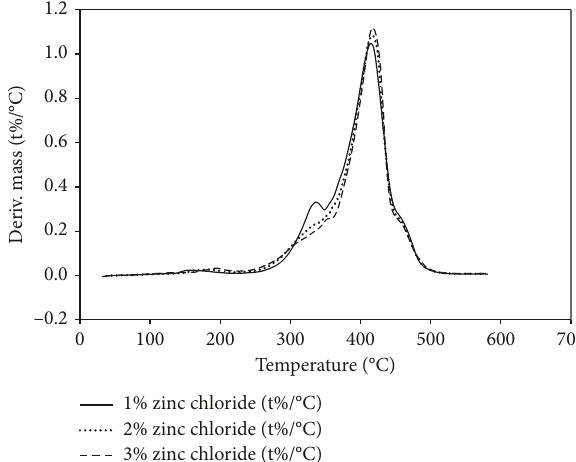
Figure 4: TGA profiles for epoxydized sunflower oil crosslinked with gluten and 1, 2, and 3% zinc chloride heated at 20 ° C/min.